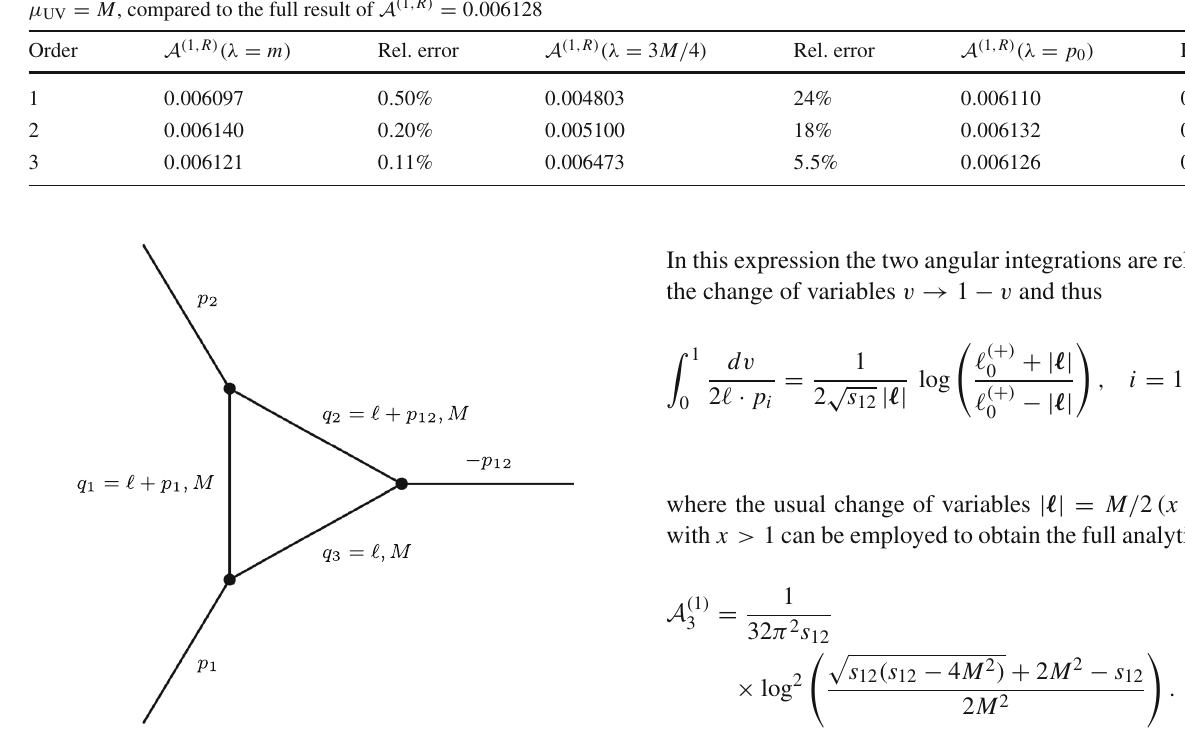
Fig. 5 The three-point function with equal internal masses with the on-shell energies q gies in the second and third on-shell cuts are